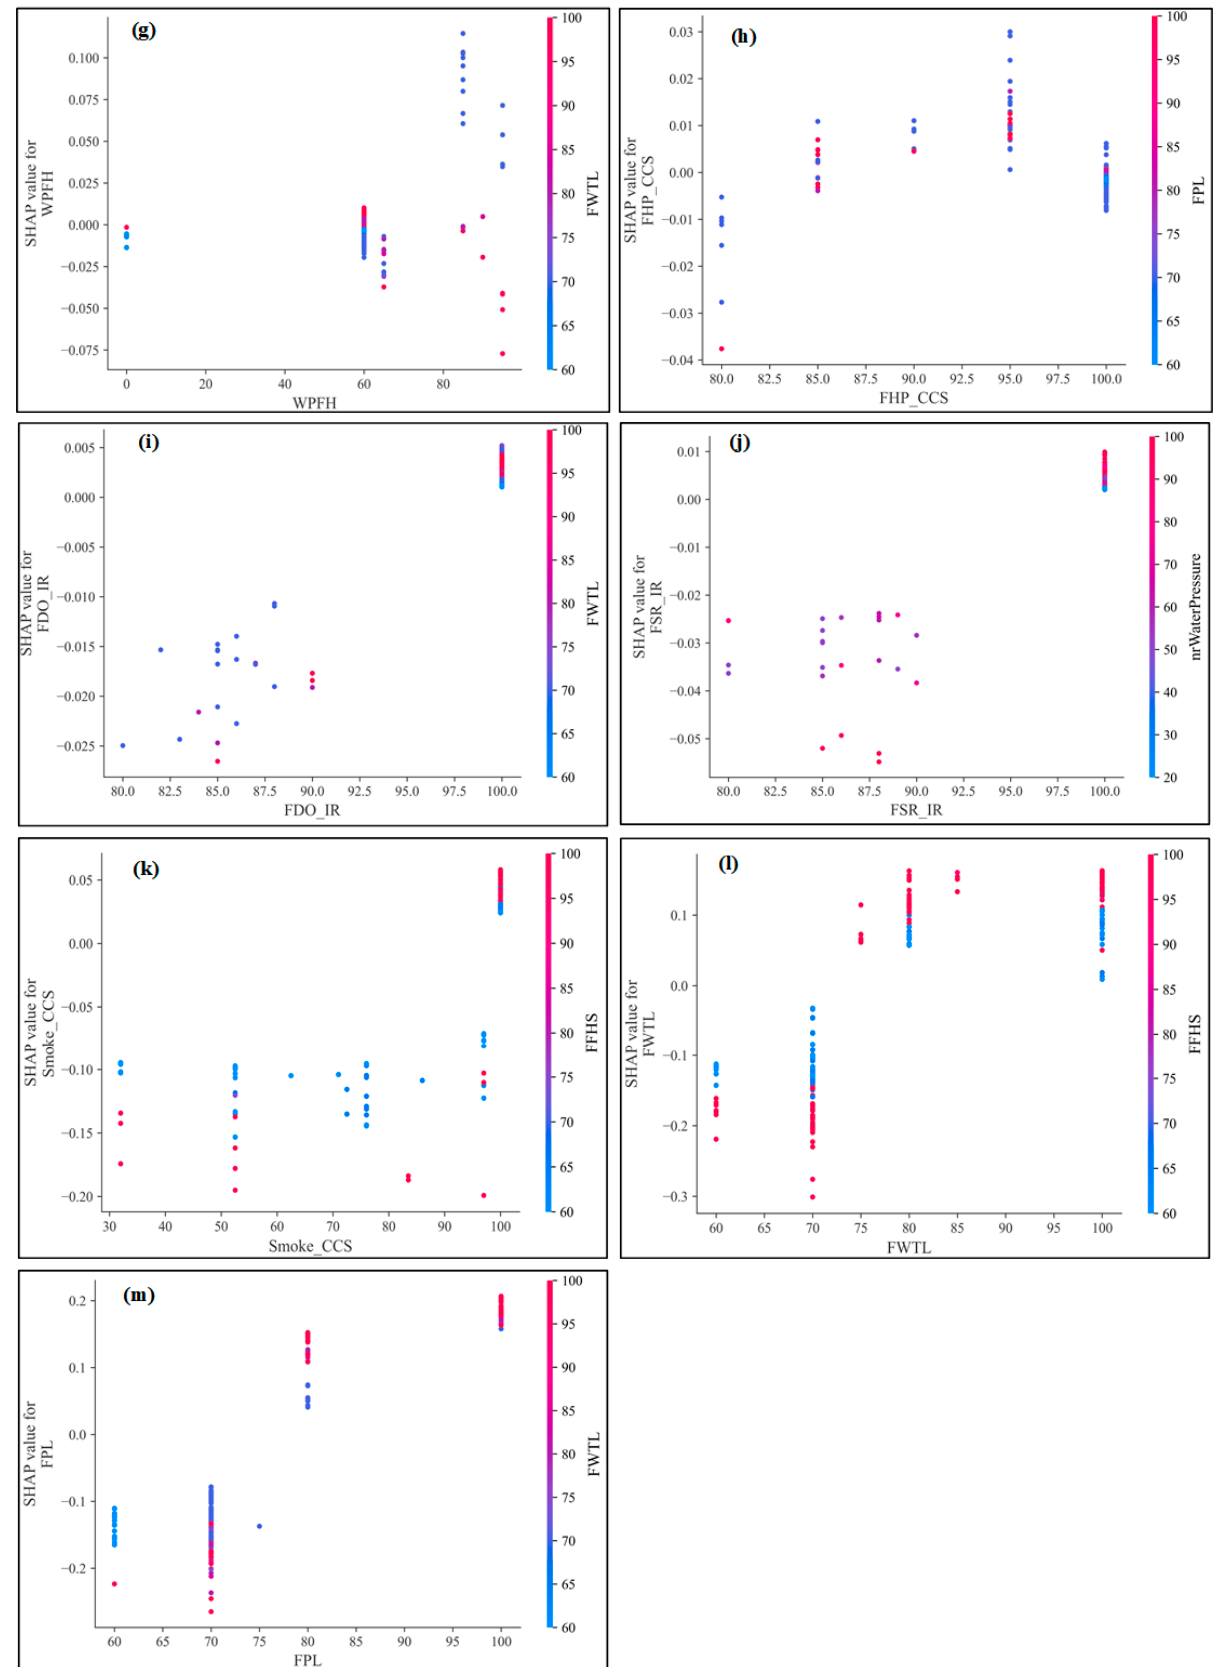
Figure 12. SHAP dependency plots for Ideal Safety mode of the equipment management database.